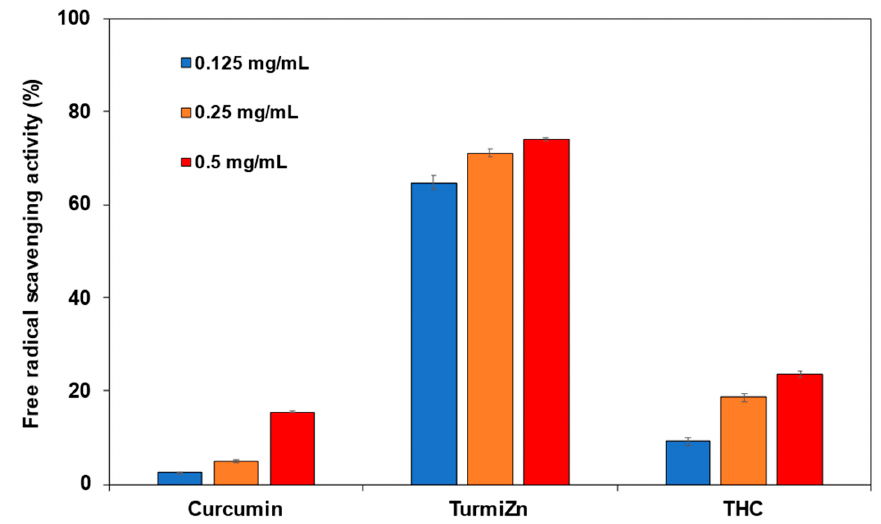
Figure 6. Antioxidant capability of TurmiZn, curcumin, and THC dose response in the DPPH assay. Values are mean ± standard error of mean.